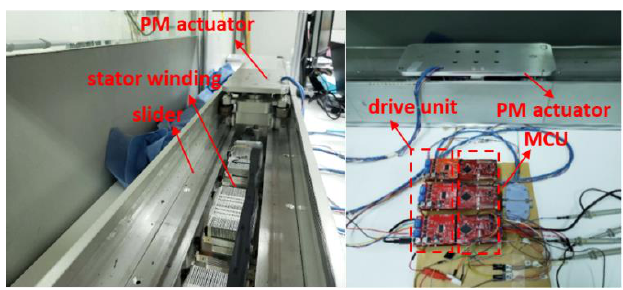
Figure 10. The experimental setup of segmented PMLSM.